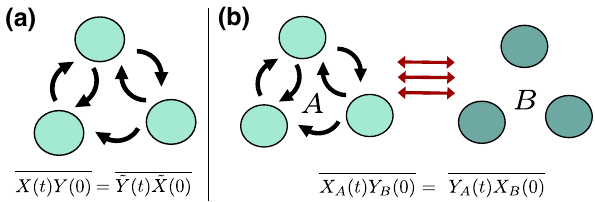
FIG. 2. (a) System with discrete microstates, described by a classical master equation. Detailed balance [Eq. (2)] is equiv- alent to a time symmetry of stationary correlation